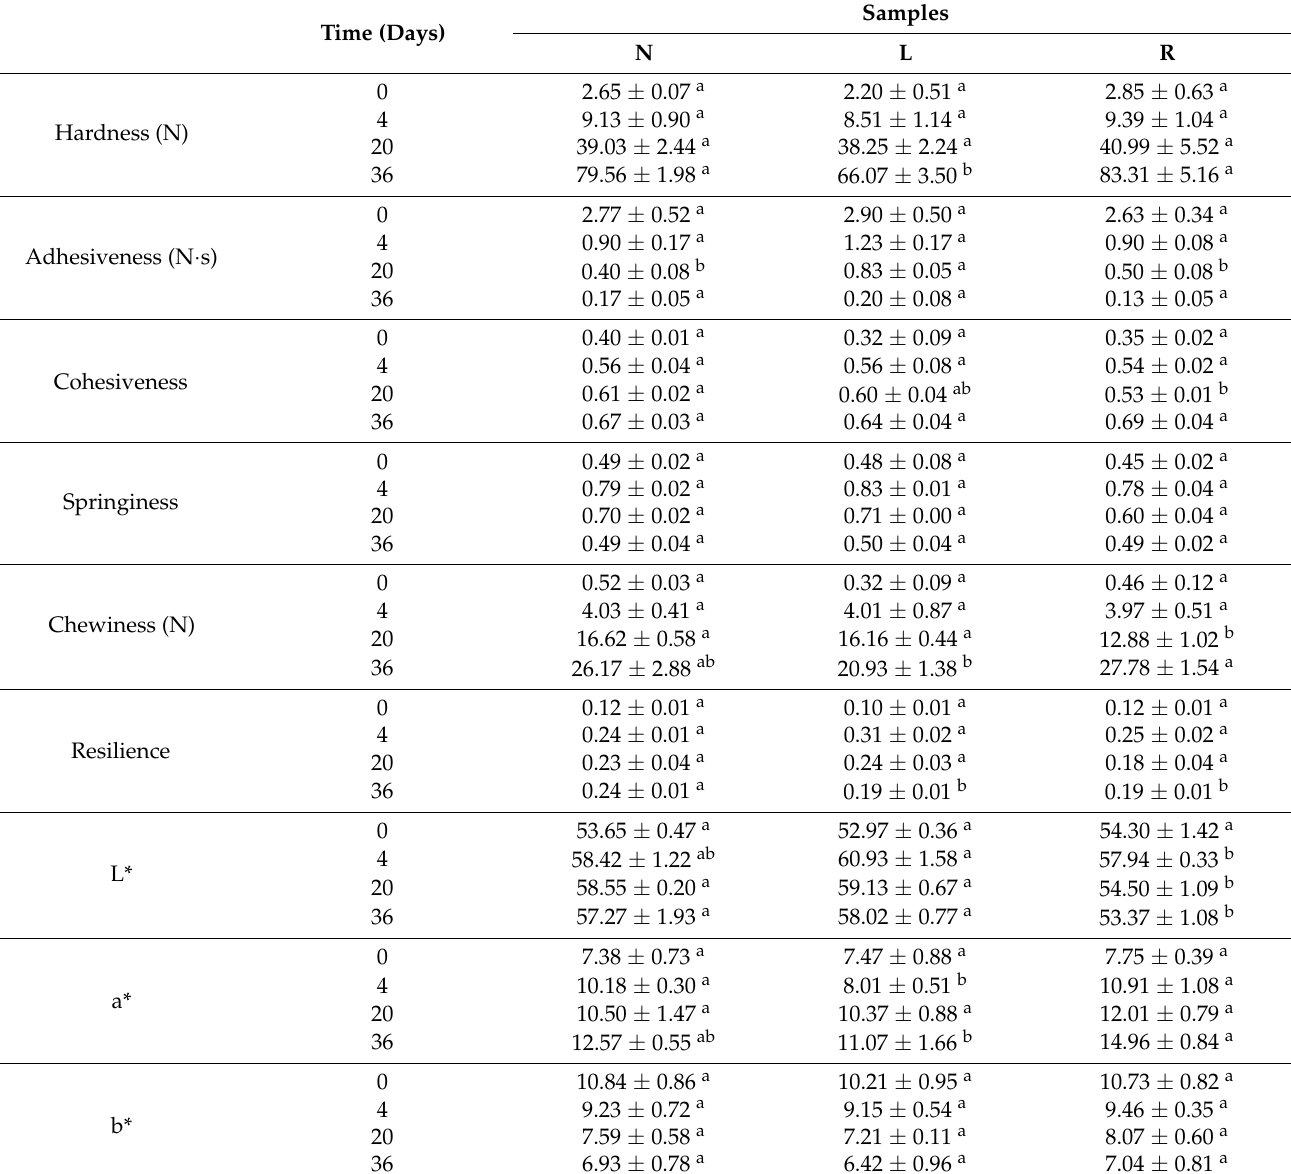
Table 2. Evaluation of TPA and color test of the fermented